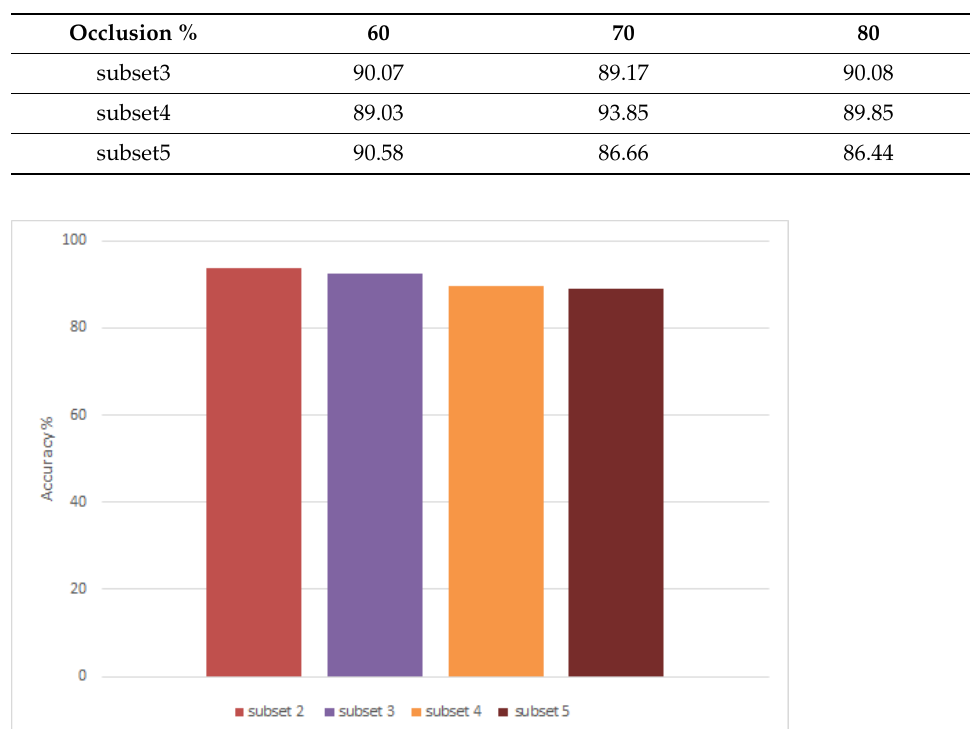
Table 3. Further Results on the Extended Yale B Datatset.